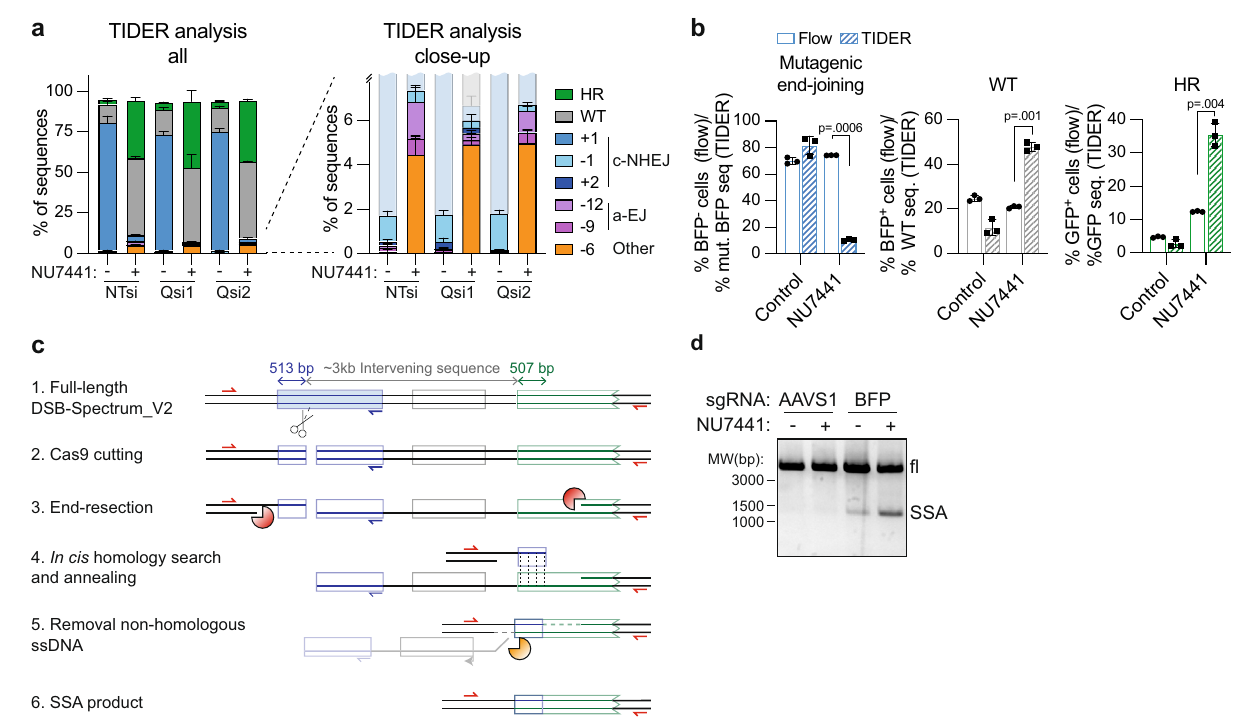
Fig. 3 | Inhibition of DNA-PKcs promotes DSB-repair by single-strand anneal- ing. a HEK 293T DSB-Spectrum_V2 cells were transfected with indicated siRNAs (NTsi=Non-Targeting control, Qsi=PolQ-targeting siRNA), followed by trans- fection with Cas9 and an BFP-targeting sgRNA. Next, cells were treated with NU7441 (2 µ M) or left untreated. At 48h after transfection, Cas9-expressing cells werecollectedbyFACSandsubjectedtosequenceanalysisofthetargetsiteusing theTIDERalgorithm.Frequencyofalldetectedsequencesisplottedintheleftbar graph, a close-up ofthe bottom fractionofthisgraphisshown onthe right( n =3; mean±SEM). b The data shown in panel a , and the data shown in Fig. 2i, were replotted to compare DSB-Spectrum_V2 editing frequencies in NU7441-treated cells as determined by either fl ow cytometry or TIDER-mediated sequence analysis ( n =3; mean±SEM; ratio paired t -test, two-tailed). c Schematic